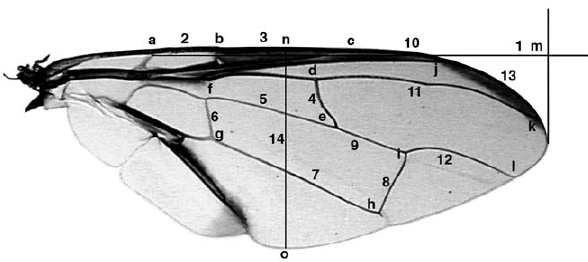
Figure 6. Wing showing points of reading taken for morpho- metric analysis.